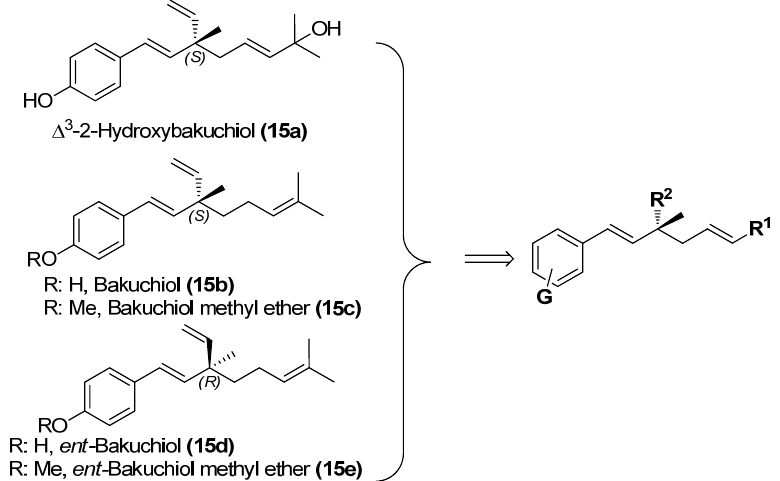
Figure 1. The structures of bakuchiol ( 15b ) and ∆ 3 -2-hydroxybakuchiol ( 15a ) and the proposed